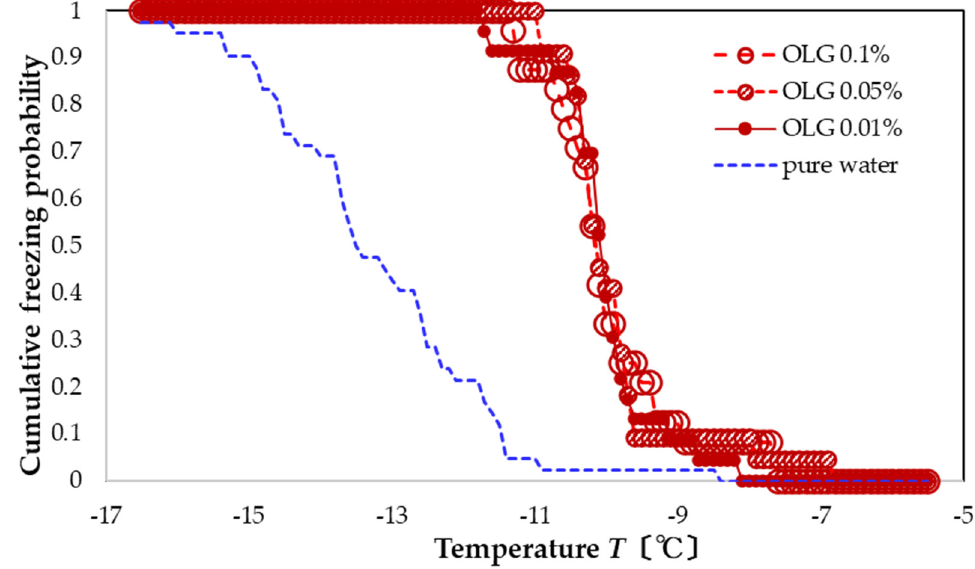
Figure 5. Freezing curves of OLG solutions. Leftmost blue-dashed curve is the freezing curve of pure